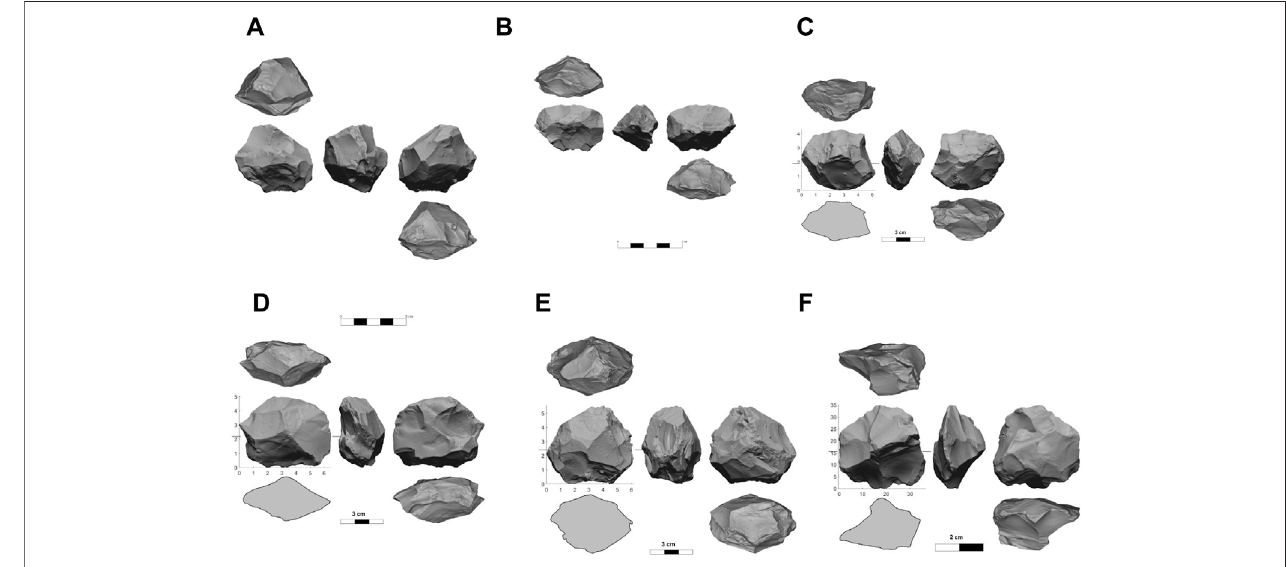
FIGURE 5 | Discoid alternate (A – E) and switchable hierarchy (F) cores from Jaljulia.